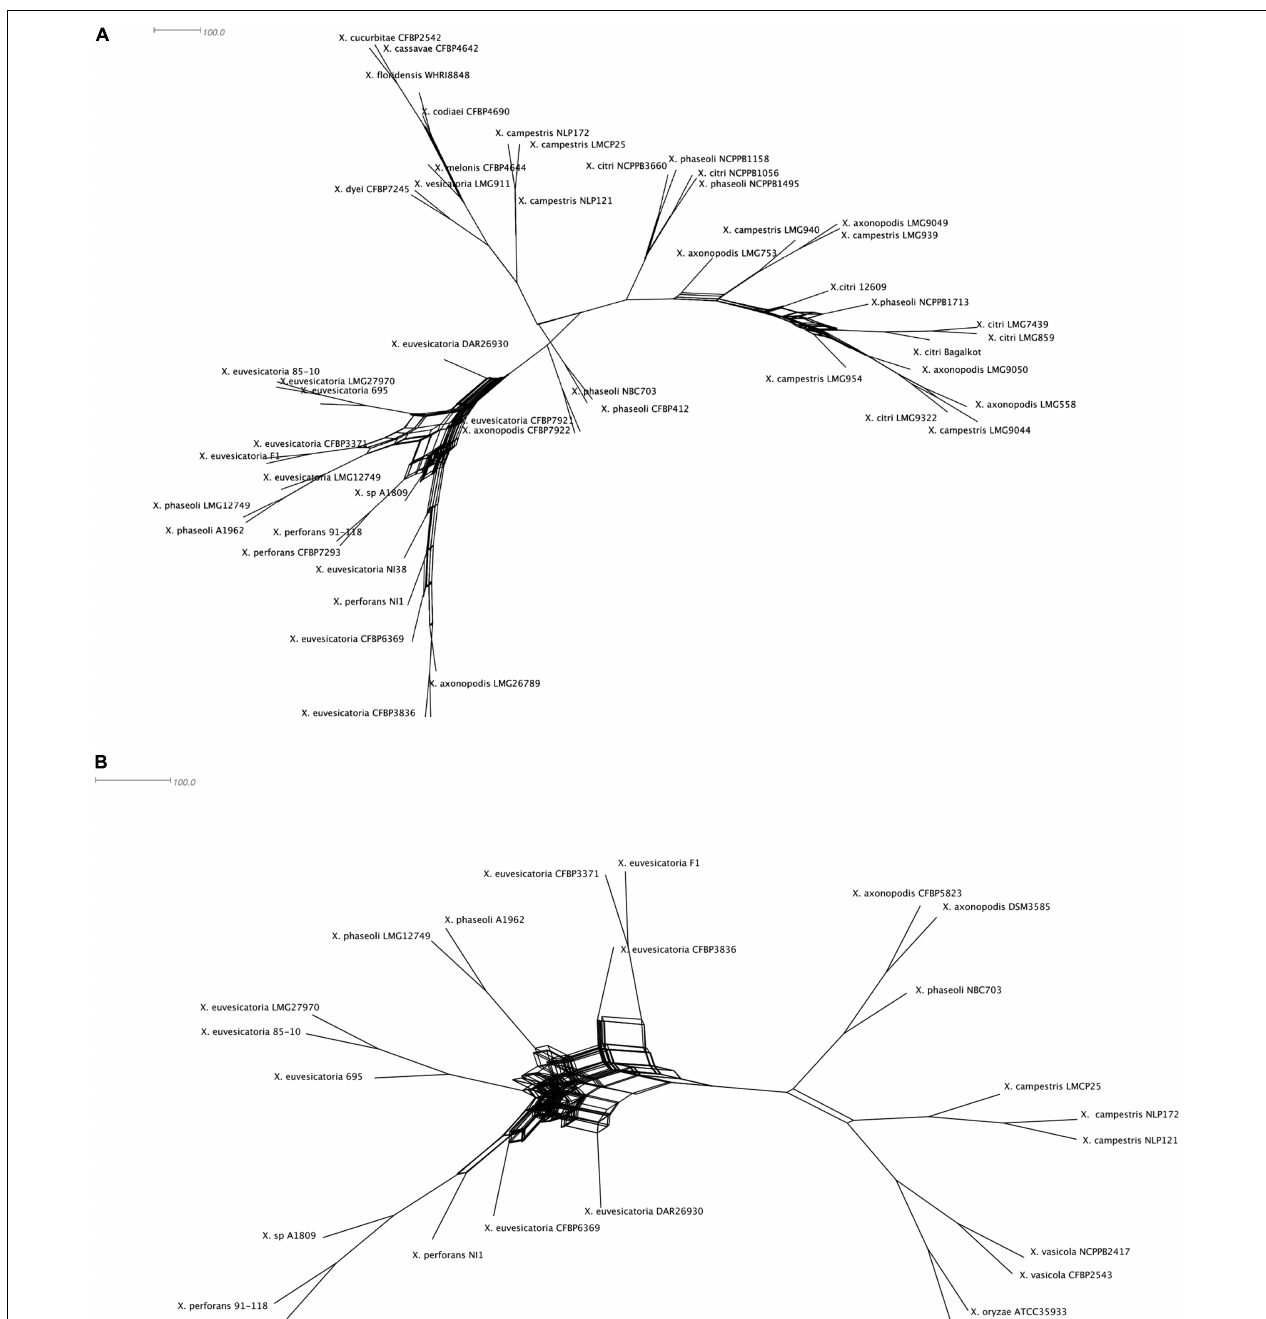
FIGURE 2 | Split decomposition tree of the selected Xanthomonas spp. demonstrating incongruencies between the MLSA-based phylogeny and (A) T6 i3* without hcp and vgrG and (B) T6 i3*** without hcp and vgrG . The figure was drawn to scale using Splitstree4. The formation of parallel lines indicates conflicting phylogeny or possible recombination